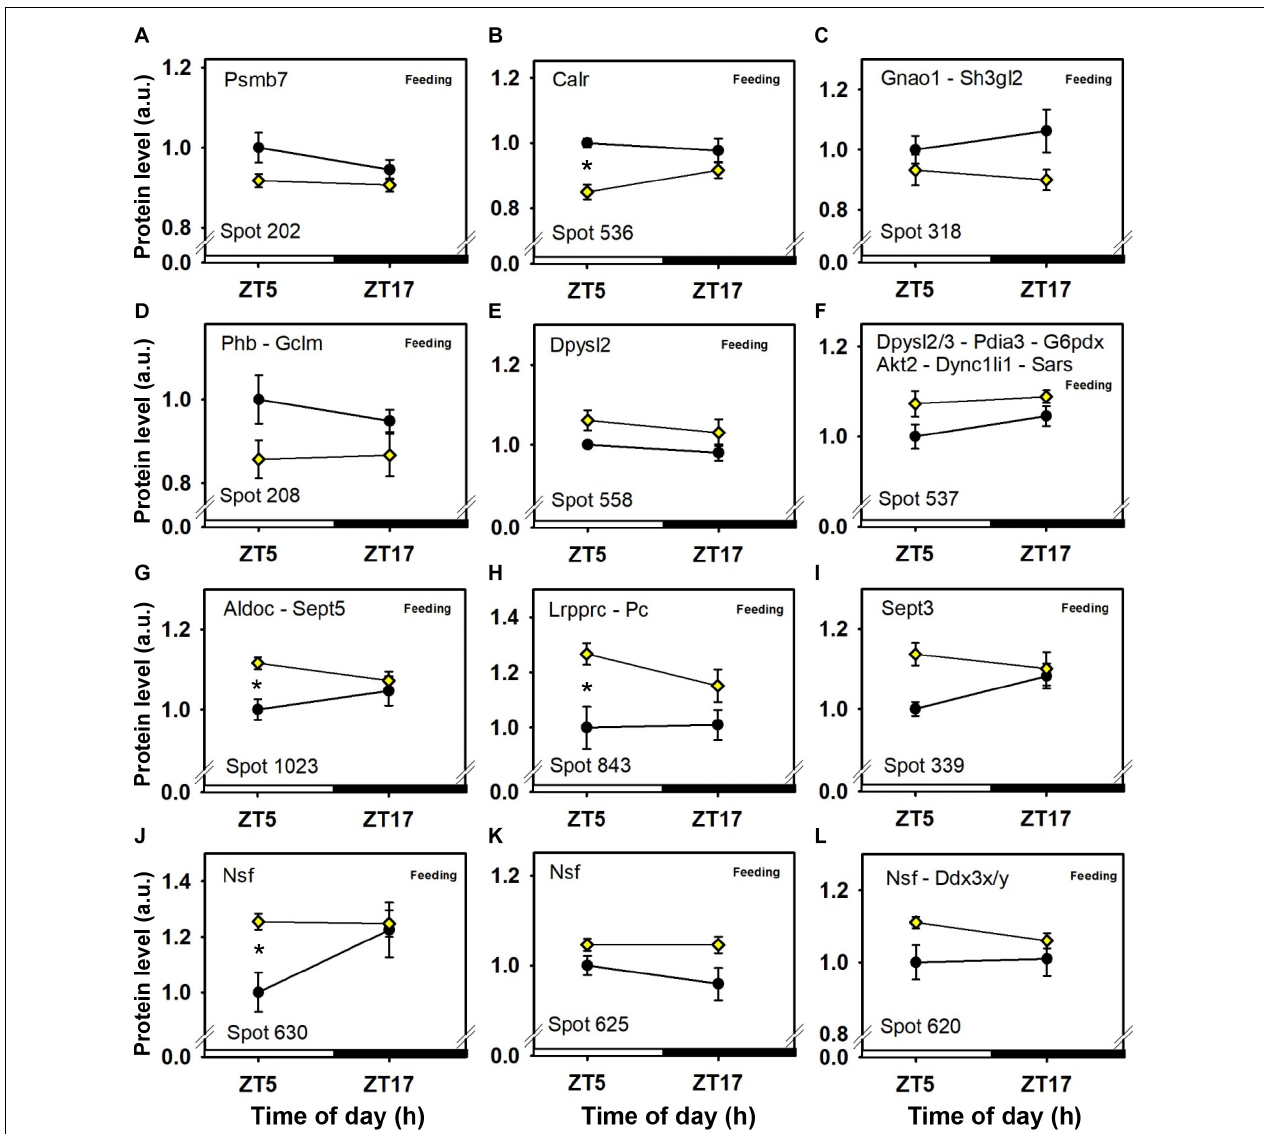
FIGURE 5 | Day–night expression of cerebellar proteins mostly affected by feeding (2/3). From analyses in control mice fed ad libitum (closed circles) and mice exposed to daytime restricted feeding (yellow diamonds), “Feeding” indicates significant ( P < 0.05) main effect of feeding conditions, as detected by two-way ANOVA (see section “Materials and Methods” for details). * P < 0.05 after post hoc Tukey comparison. Different part labels have been attributed to each differentially-expressed proteins; see details in the main text.